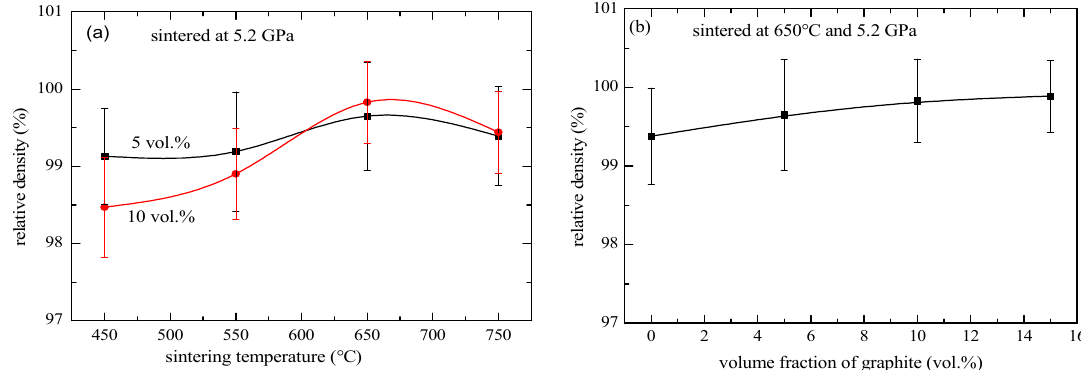
Figure 3. E ff ect of ( a ) sintering temperature and ( b ) graphite content on the relative density of the G / 6061Al.